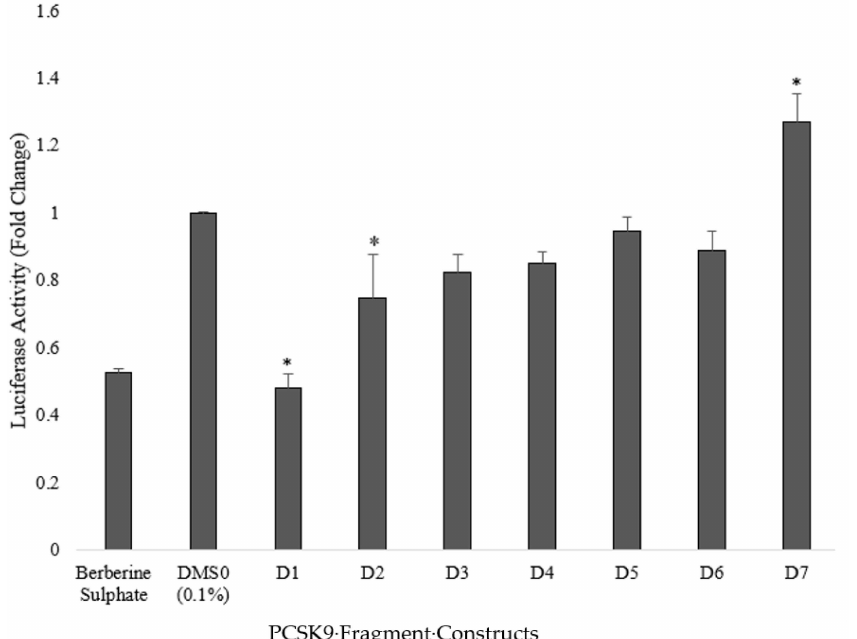
Figure 5. Inhibitory effect of A. planci on PCSK9 promoter fragments. Transient transfection was carried out on 7 different PCSK9 promoter constructs (D1–D7) in the HepG2 cell line, and cells were treated with 6.25 µ g/mL of the selected fraction. Luciferase assays were then conducted on cell lysates. One-way ANOVA was used for statistical analysis comparing treated transfected HepG2 cells with the untreated control. * denotes statistical significance ( p < 0.05) compared with the untreated control. Thus, cis-acting elements present in the D1 fragment only ( − 1711/ − 1214) were re- sponsible for producing the lowest inhibitory effect of A. planci on PCSK9 transcriptional activity and are, therefore, a subject for further investigation to determine the role of PPRE in mediating the inhibitory effects of the selected